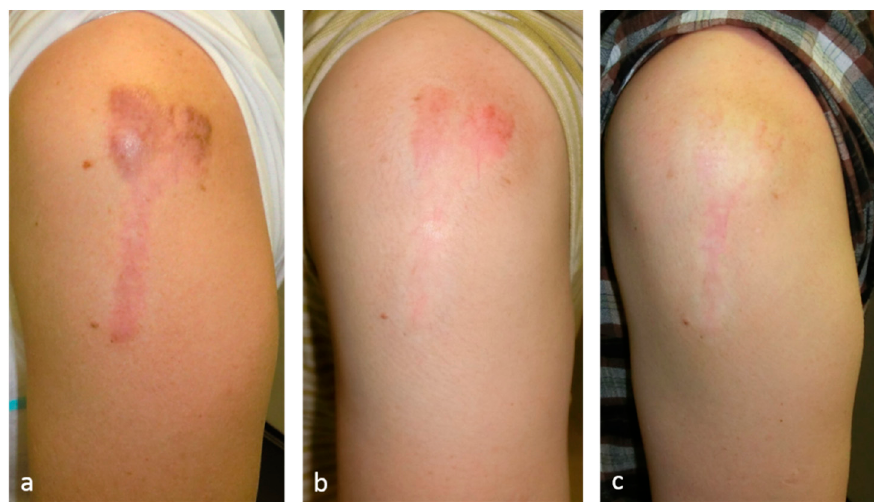
Figure 4. This 60-year-old female had a mild keloid that was treated by 1064 nm long-pulsed Nd:YAG laser. Long-pulsed 1064 nm Nd:YAG laser was used at the following settings: 5 mm spot diameter, 75 J/cm 2 , 25 msec, and 2 Hz. After 1 year of treatment, the scar had almost disappeared. The known target of long-pulsed Nd:YAG lasers is the blood vessels. Thus, we speculate that laser therapy largely treats pathological scars by decreasing blood vessel numbers, thereby inhibiting the inflammatory signals coming from the blood vessels. ( a ) Pretreatment view; ( b ) after 10 months of treatment; and ( c ) after 16 months of treatment.